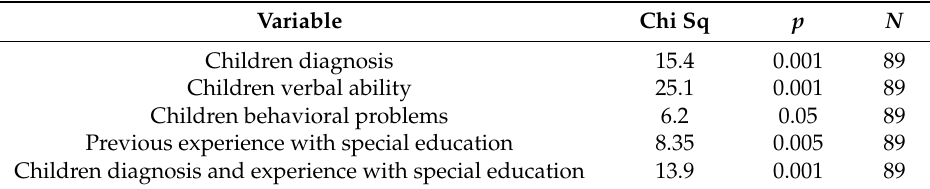
Table 3. Parental future schooling preferences for their children with special